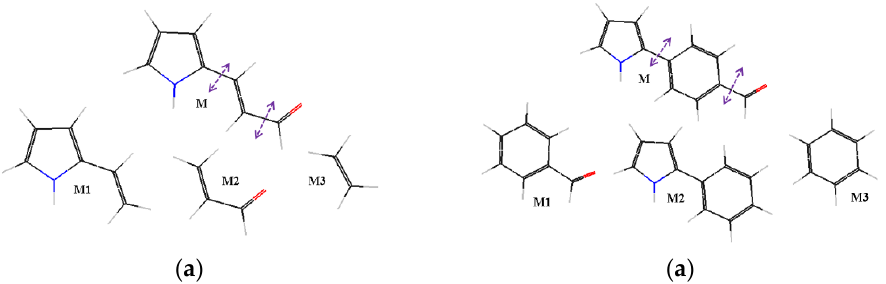
Scheme 6. Fragmentation scheme for the E π (PPE) value calculation for compound with the double bond as π‐ bridge ( a ) and the phenyl ring as π‐ bridge ( b ).